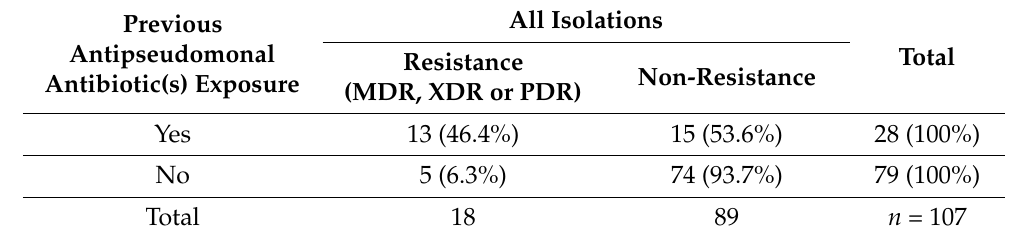
Table 6. The case–control analysis for the resistant PA infections and the previous antipseudomonal antibiotic(s)